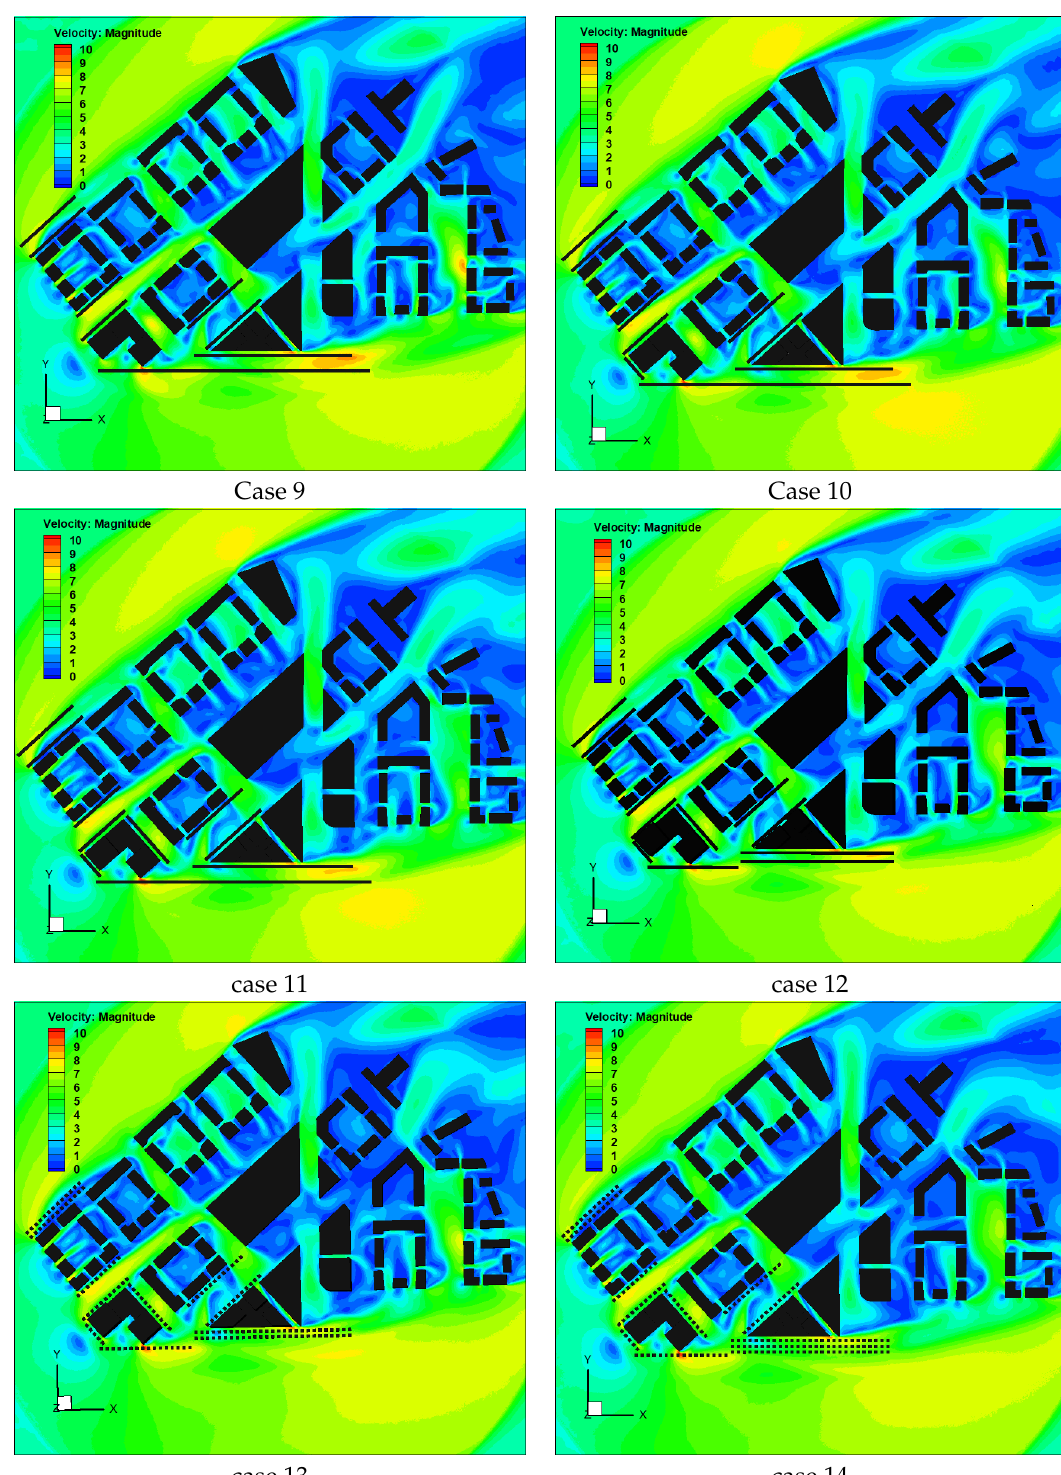
Figure 11. Velocity contours at the pedestrian level (2 m) with various tree arrangements and tree height of 15 m: ( case 9 ) minimum distance to buildings: H/4, distance to other trees: adjacent, ( case 10 ) minimum distance to buildings: H/4, distance to other trees: adjacent, ( case 11 ) minimum distance to buildings: H/4, distance to other trees: adjacent, ( case 12 ) minimum distance to buildings: adjacent, distance to other trees: 2H, ( case 13 ) minimum distance to buildings: H/4, distance to other trees: H/4, ( case 14 ) minimum distance to buildings: H/4, distance to other trees: